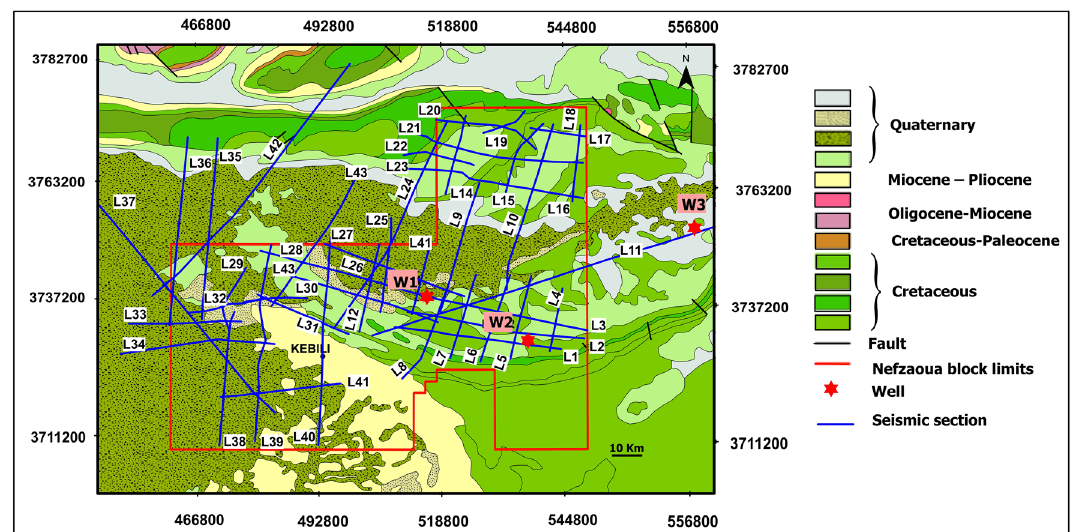
Fig. 4 Seismic reflection profiles location Fig. 5 Characterization of the Berriasian series using well logs (W1